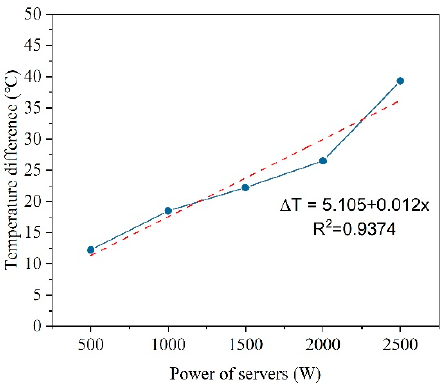
Figure 12. Differences in server surface temperature between intervals of 10 mm and 30